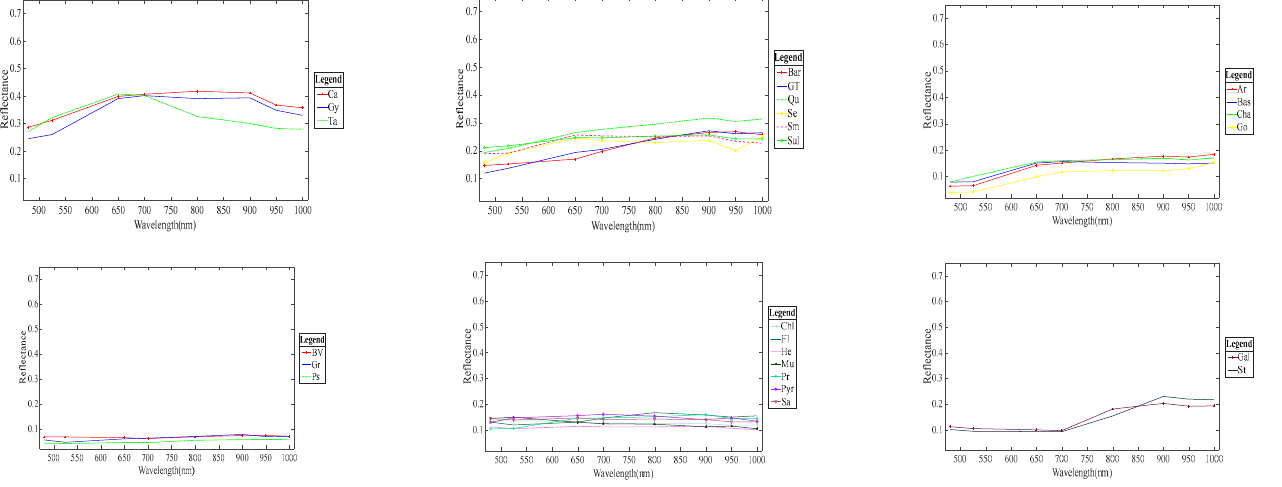
Figure 2. Illustration of spectral curves corresponding to rocks and minerals. For abbreviation, mus-